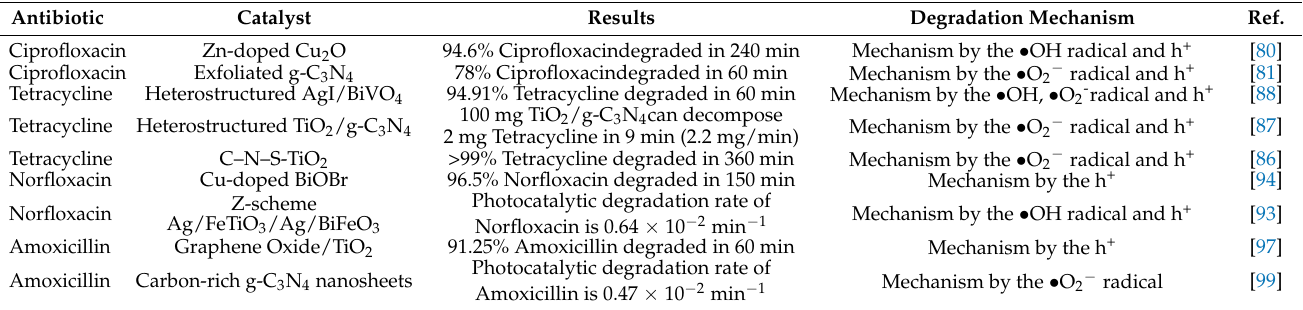
Table 1. Comparison of the photocatalytic activity of different photocatalysts for antibiotic